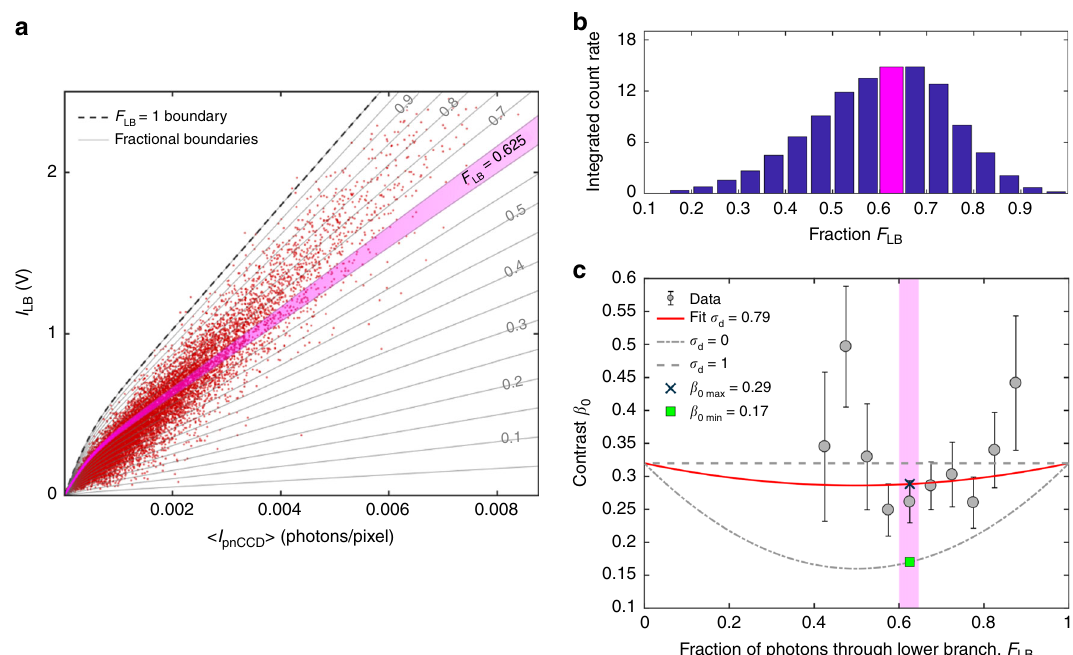
Fig. 3 Static split-pulse speckle contrast. a Fraction F LB of photons passing through the lower branch derived from the lower branch intensity monitor signal 4 FEL pulses. The non-linear form of the boundary F I V ) as a function of the pnCCD signal ( I = 1 is due to the optical setup LB ( pnCCD ) for 1.5 × 10 LB con fi guration and the spiky nature of the FEL spectrum (see Supplementary Note 2). b Histogram of the integrated count rates (see Supplementary Fig. 5) at selected q = 0.157 nm − 1 as a function of F LB . c Contrast observed for the static sample as a function of the F LB . The best fi t (red line) of Eq. (3) to the data yields a decoherence factor σ d of 0.79 ± 0.35. The limiting cases for perfectly aligned ( σ d = 1) and fully decoherent ( σ d = 0) are also shown by dashed and dashed-dotted lines, respectively. The magenta bar represents the contrast values for fraction F LB = 0.625 ± 0.025. The expected limiting contrast values are 0.29 and 0.17 as shown by blue cross and green square respectively. The error of data points was calculated based on Supplementary Eq.